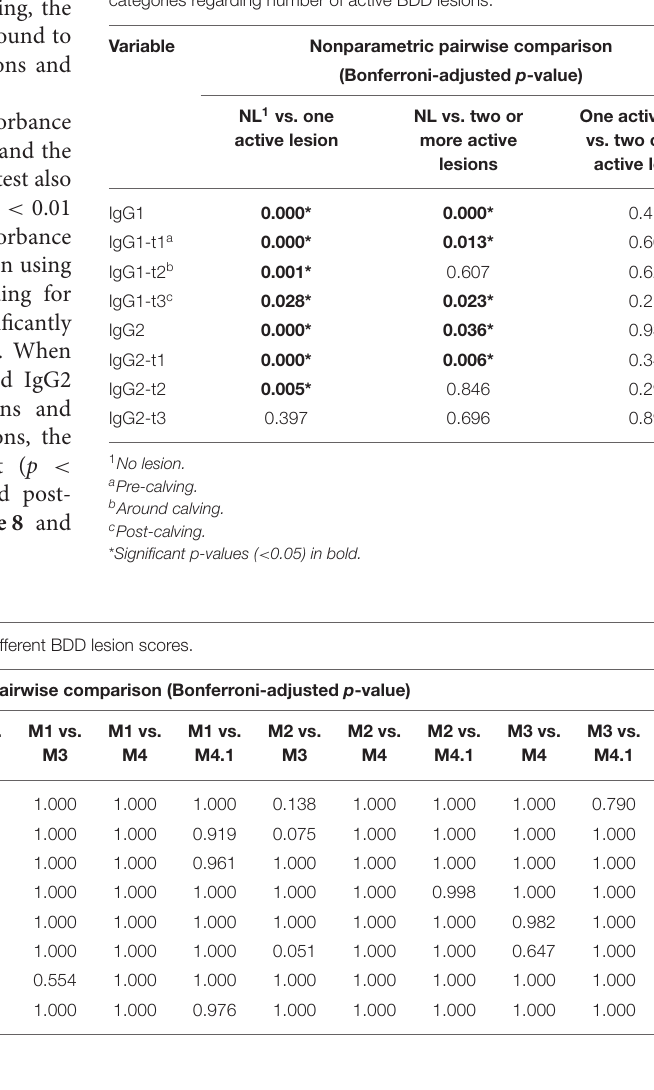
TABLE 8 | Pairwise comparison of mean absorbance readings across different categories regarding number of active BDD lesions.